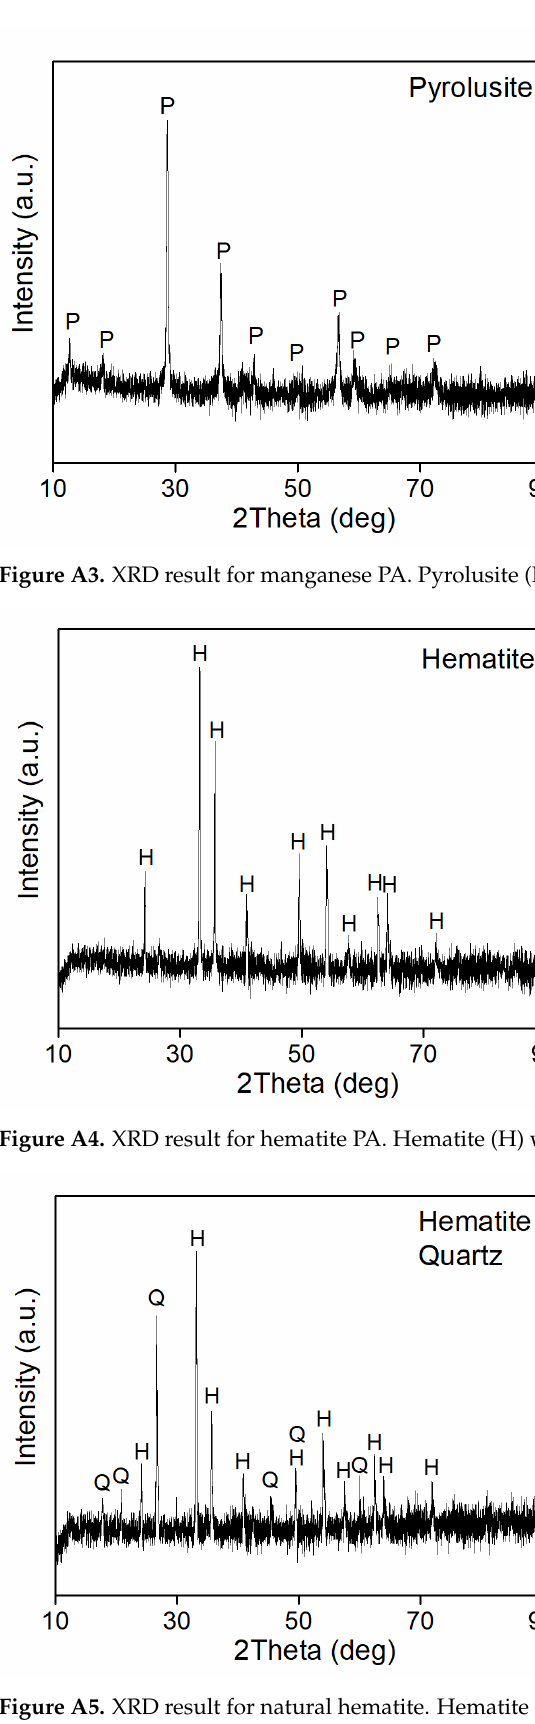
Figure A6. XRD result for burned umber. Hematite (H) was identified.